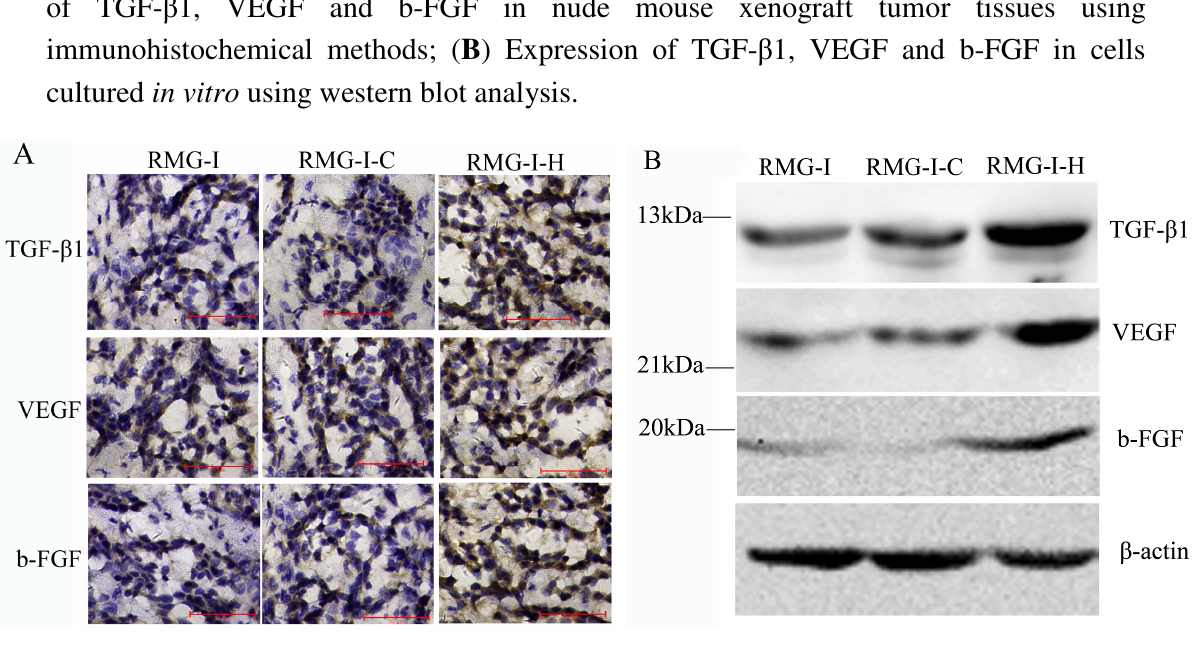
Figure 5. Determination of the expression of TGF- β 1, VEGF and b-FGF. ( A ) Expression of TGF- β 1, VEGF and b-FGF in nude mouse xenograft tumor tissues using immunohistochemical methods; ( B ) Expression of TGF- β 1, VEGF and b-FGF in